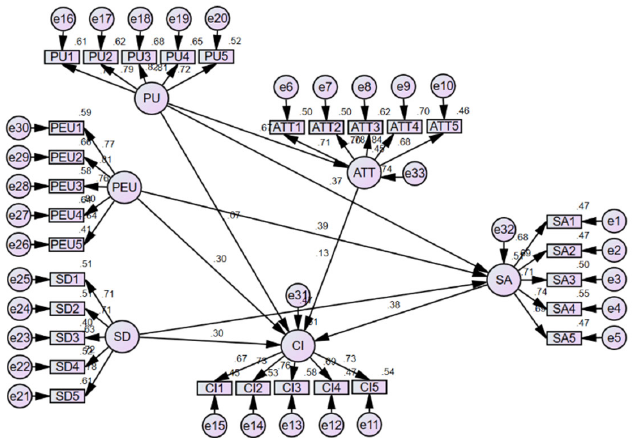
Fig. 3. Structural Equation Model